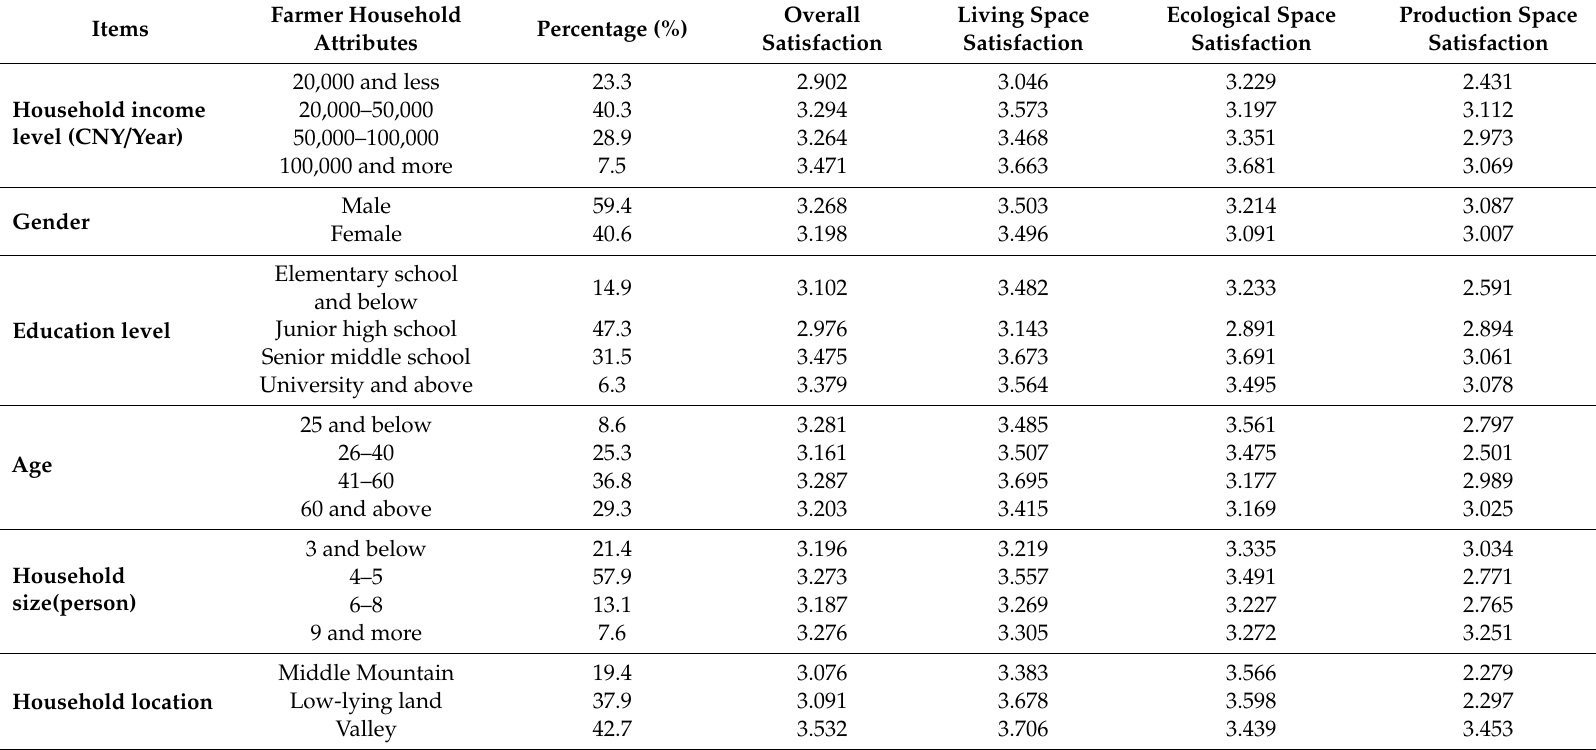
Table 3. Satisfaction scores for land spaces based on farmers’